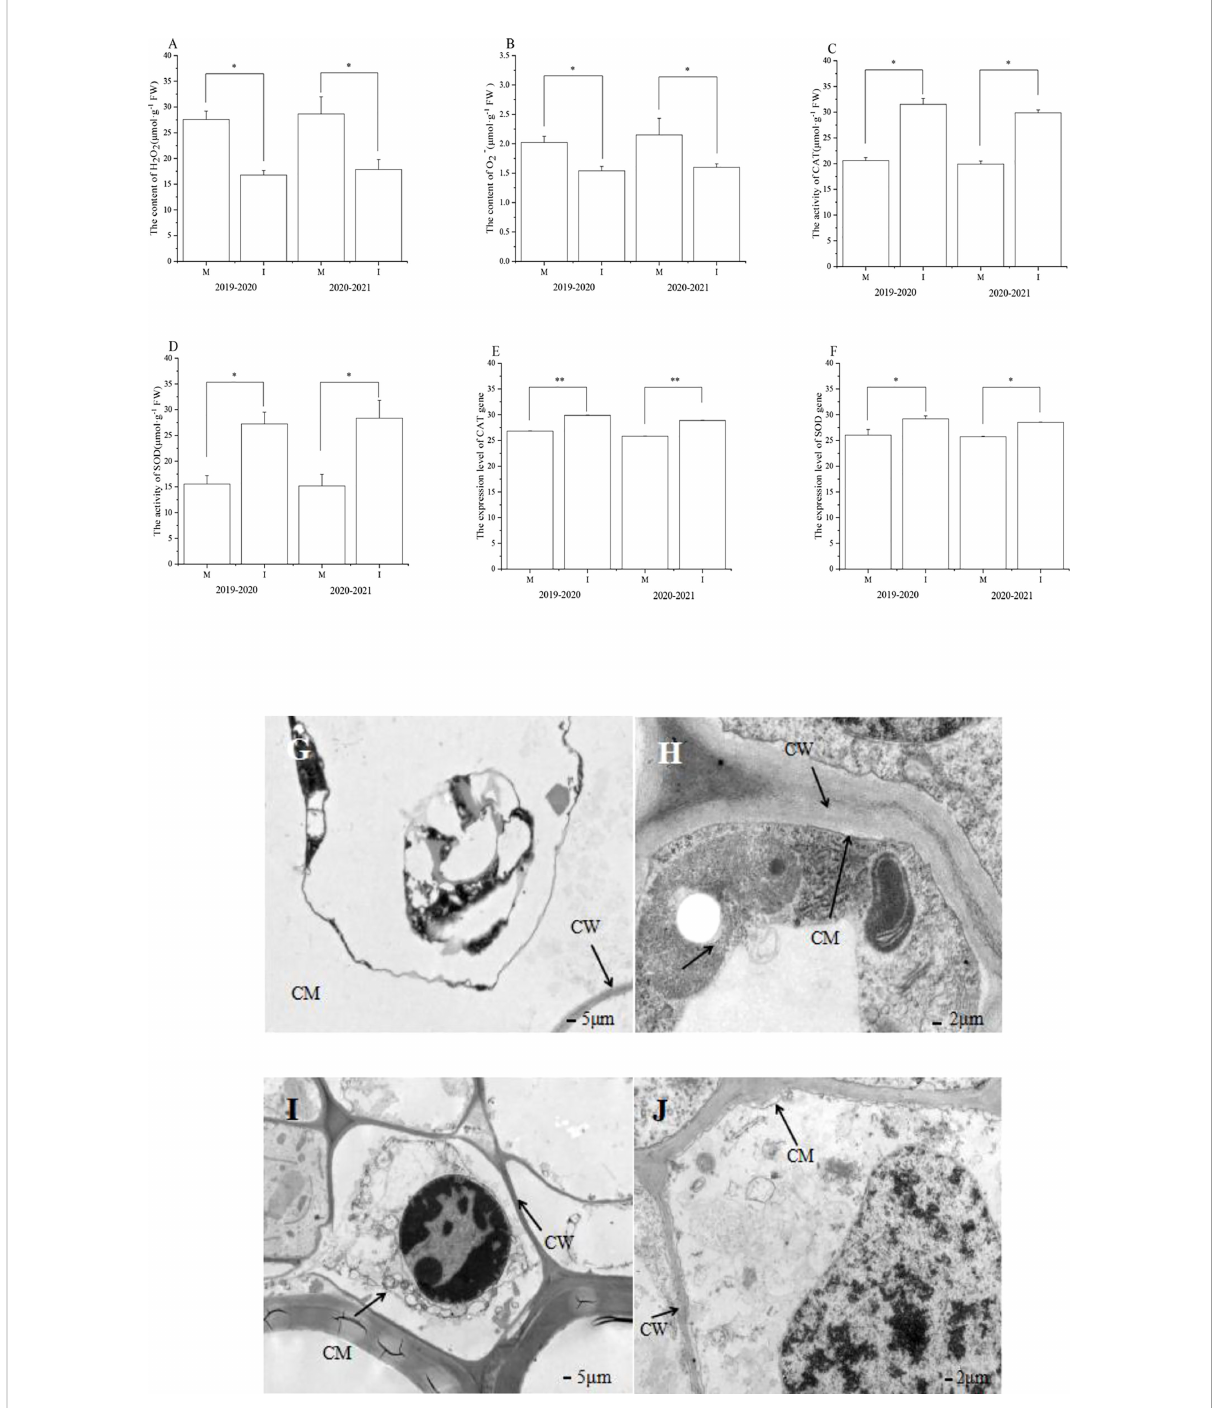
FIGURE 2 In the fi eld experiment, (A) H 2 O 2 and (B) O 2 − contents, (C) CAT and (D) SOD activity, (E) CAT and (F) SOD level of expression, and (G – J) ultrastructure of faba bean ( Vicia faba ) root system under different planting modes was studied. M, faba bean monocropping; I, wheat – faba bean intercropping; CW, cell wall; CM, cell membrane. The data represent the mean ± standard error of three biological replicates. * p < 0.05 (Tukey ’ s test). CAT, catalase; SOD, superoxide